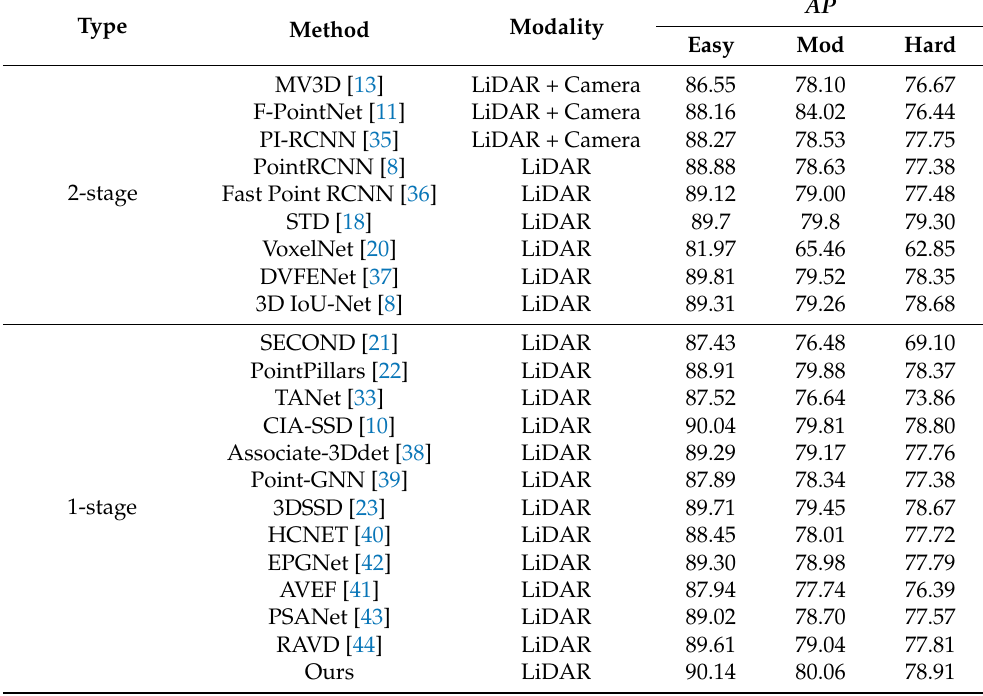
Table 2. Results of the KITTI validation set using the car